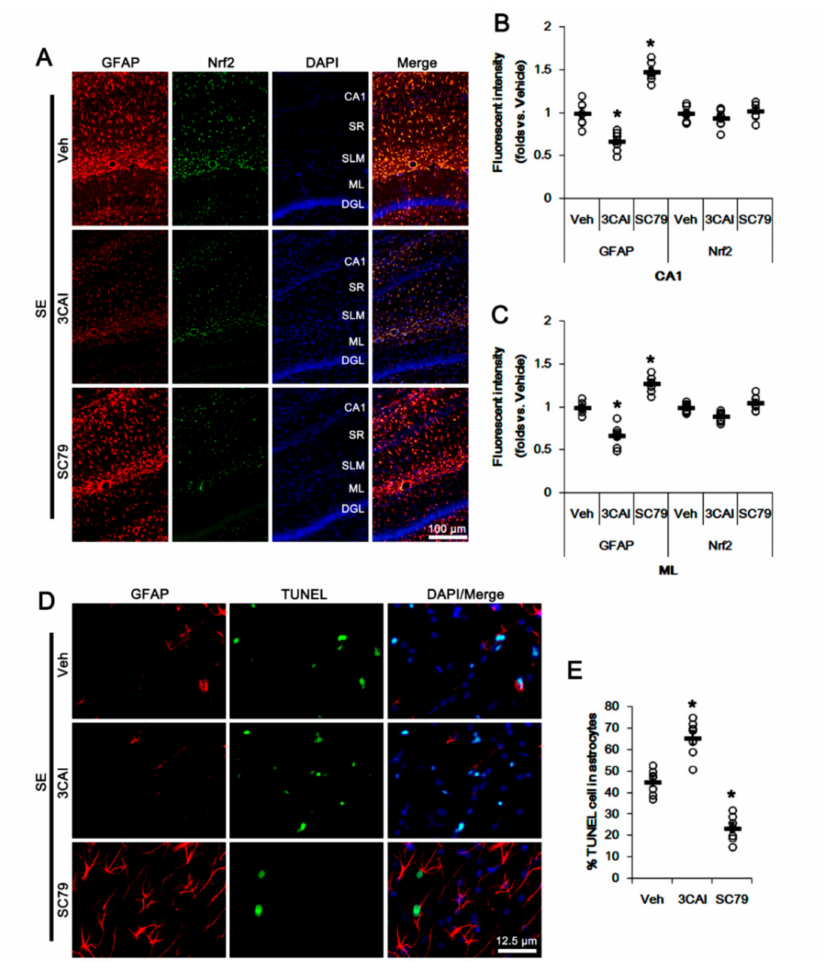
Figure 4. E ff ects of 3CAI and SC79 on Nrf2 expression and astroglial responses following SE. 3CAI attenuates reactive CA1 astrogliosis but deteriorates ML astroglial apoptosis, which are reversed by SC79. Neither 3CAI nor SC79 a ff ects Nrf2 expression in CA1 astrocytes and ML astrocytes following SE. ( A ) Representative photos of GFAP and Nrf2 in the hippocampus. Abbreviations: CA1, CA1 pyramidal cell layer; SR, stratum radiatum; SLM, stratum lacunosum-moleculare; ML, molecular layer of the dentate gyrus; DGL, dentate granule cell layer. ( B , C ) Quantification of the fluorescent intensities of GFAP and Nrf2 in CA1 ( B ) and molecular layer regions ( C ). Open circles indicate each individual value. Horizontal bars indicate mean value. Vertical bars indicate S.E.M. (* p < 0.05 vs. vehicle, one-way ANOVA followed by Newman-Keuls post hoc test; n = 7, respectively). ( D ) Representative photos of apoptosis of ML astrocytes. ( E ) Quantification of the fraction of TUNEL-signals in ML astrocytes. Open circles indicate each individual value. Horizontal bars indicate mean value. Vertical bars indicate S.E.M. (* p < 0.05 vs. vehicle, one-way ANOVA followed by Newman-Keuls post hoc test; n = 7,